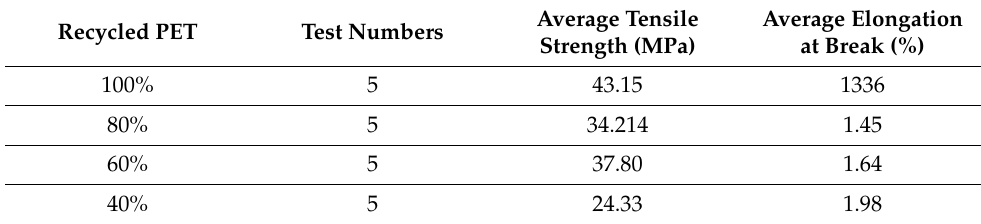
Table 6. Tensile strength and elongation at break of recycled PET